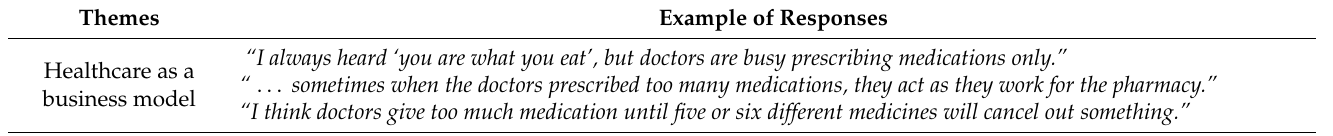
Table 3. Themes derived from responses given by the study respondents (N = 21) in the domain of perceived